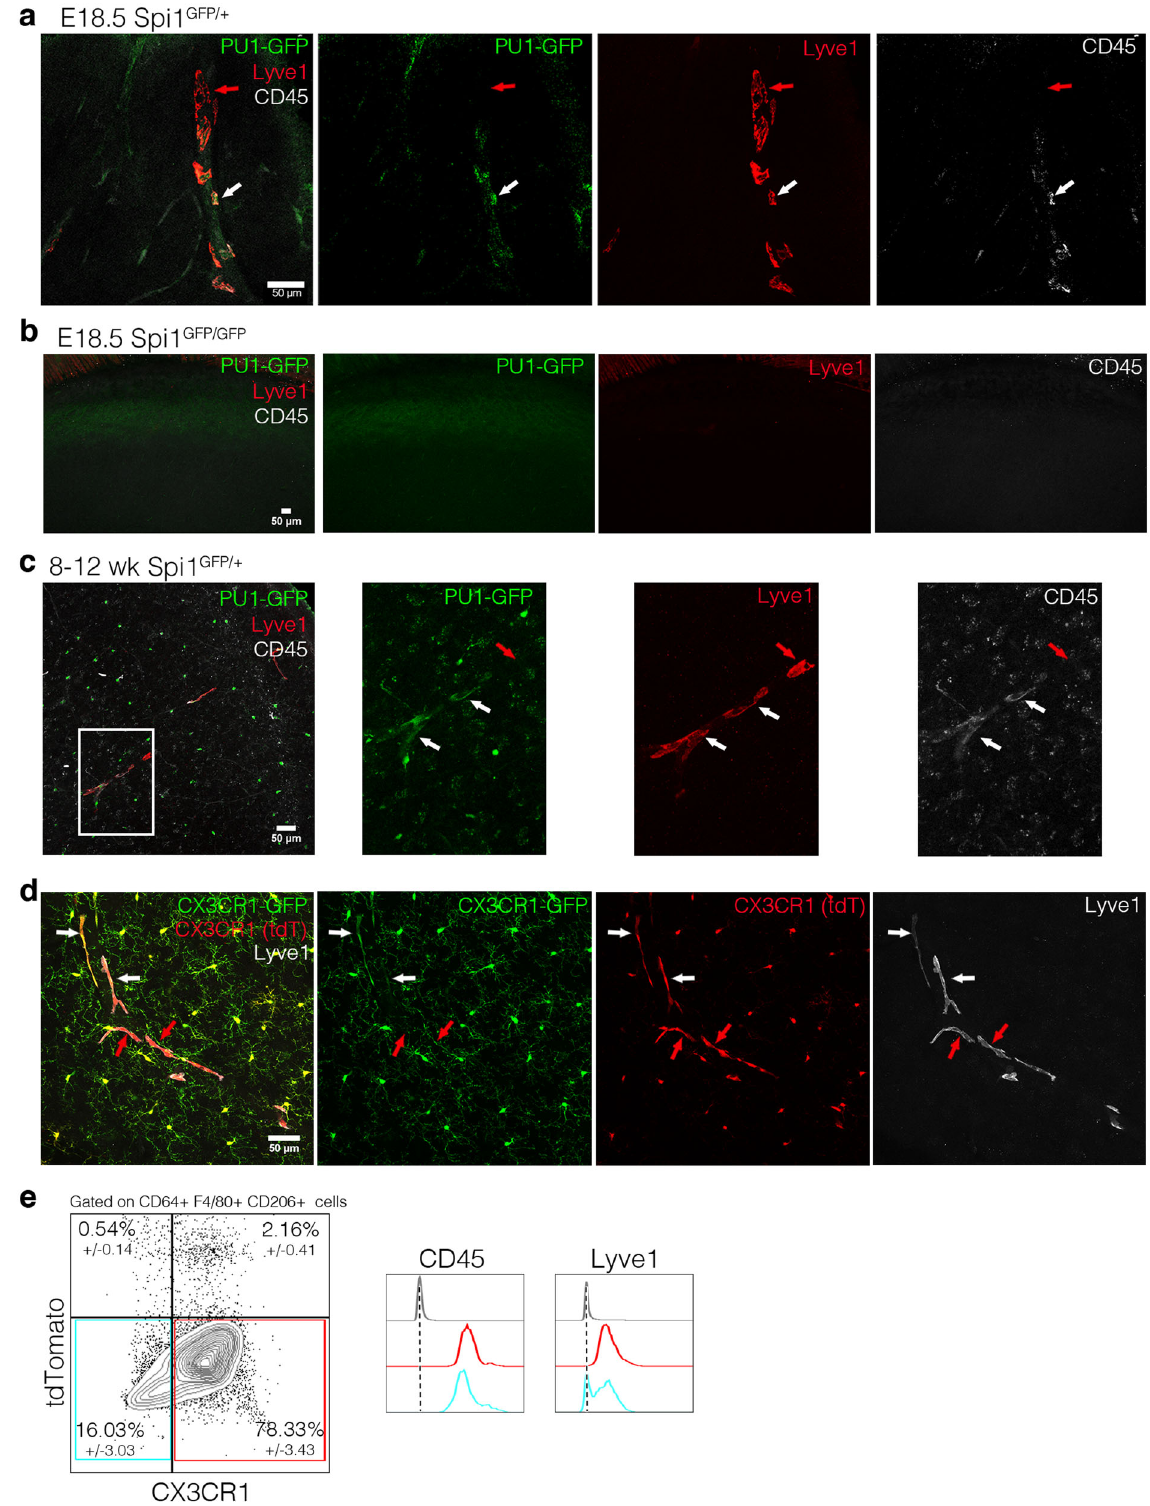
Fig. 5 | The origin of CX3CR1 – Lyve1 + perivascular macrophages. a Immuno fl uorescenceonsectionsoftheheadofaE18.5 Spi1 GFP/+ embryo(PU1-GFP in green), labeled for Lyve1 (red) and CD45 (white) (60 µ m maximum intensity projection) shows the presence of the conventional (white arrows) and the non- conventionalpvMpopulations(redarrows)atthisstage( n =3). b NoGFPnorLyve1 fl uorescence was observed in the Spi1 GFP/GFP E18.5 dorsal cortex (33 µ m maximum intensity projection) ( n =2). c Immuno fl uorescence on Spi1 GFP/+ adult mouse brain (48 µ m maximum intensity projection) ( n =3). d Immuno fl uorescence on sections